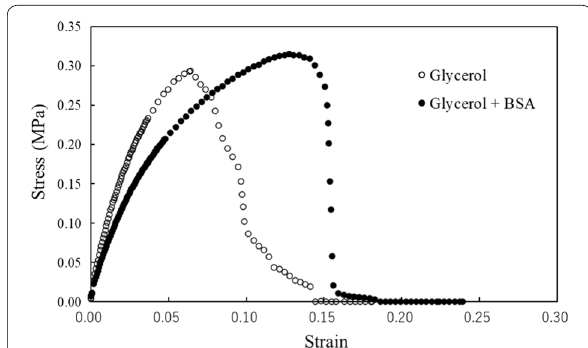
Fig. 5 Young’s modulus and tensile strength Stress–Strain curves of cell-plastic (Gly) (white circle) and cell-plastic (Gly-BSA) (Black circle). Their tensile strengths (maximum stresses) and Young’s modulus (slope of the initial growth) are detected to be 0.29 MPa and 9.0 MPa (white circle), and 0.32 MPa and 6.2 MPa (Black circle), respectively